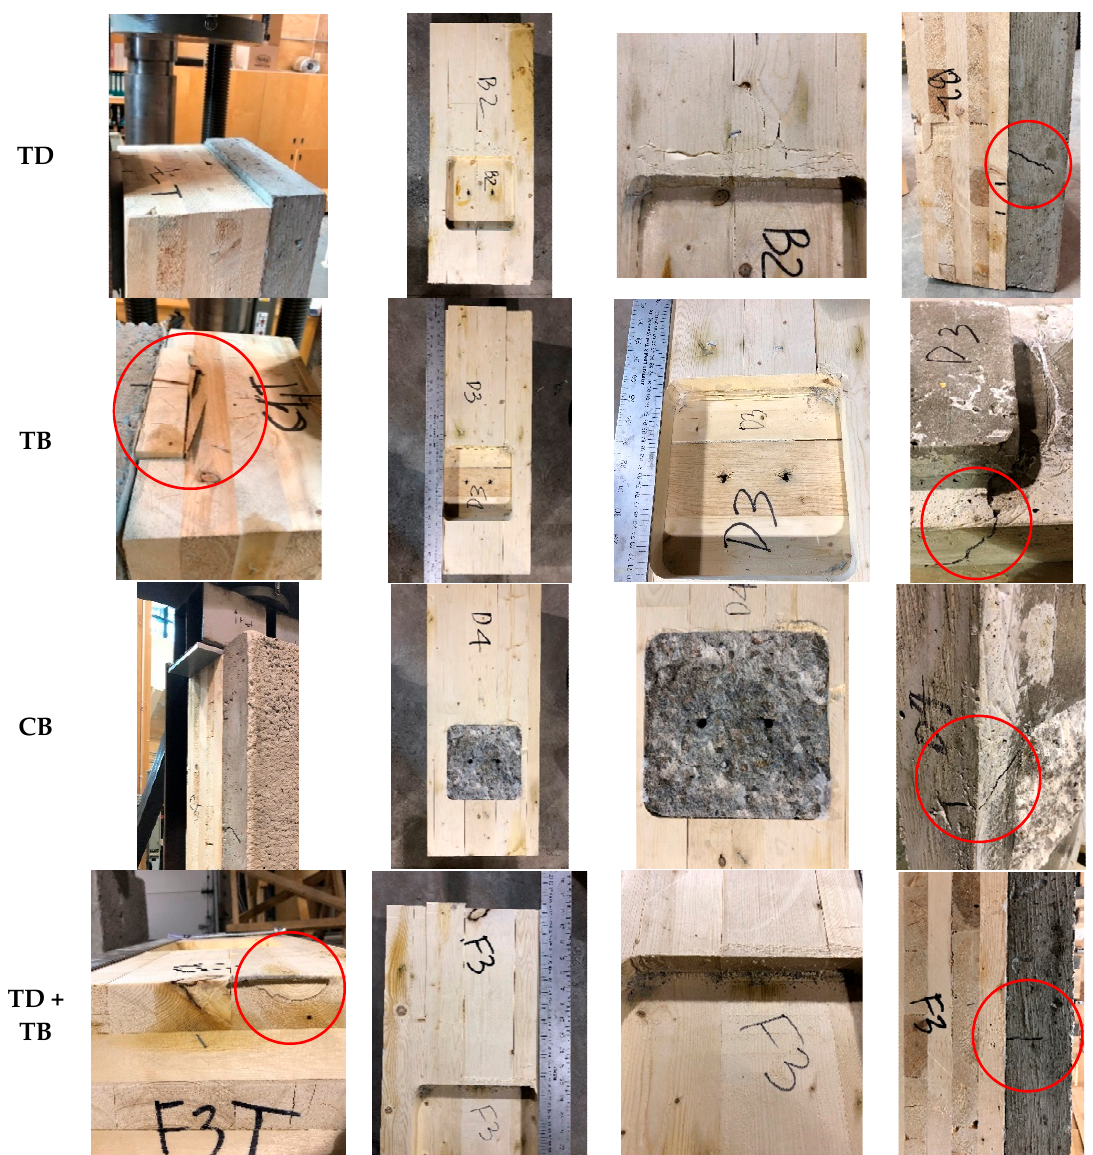
Figure 12. Load-slip curves of different failure types.